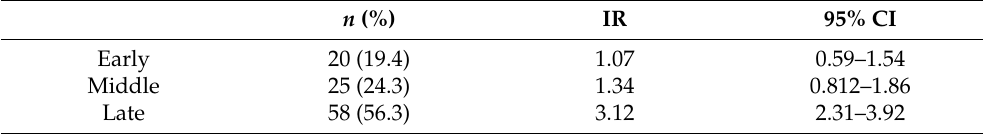
Table 4. Percentage of injuries, injury rate (number of injuries per 1000 h of exposure) and 95% confidence intervals (CI) occurring in the first (early), second (middle) or final (final) one third of a game or training session.